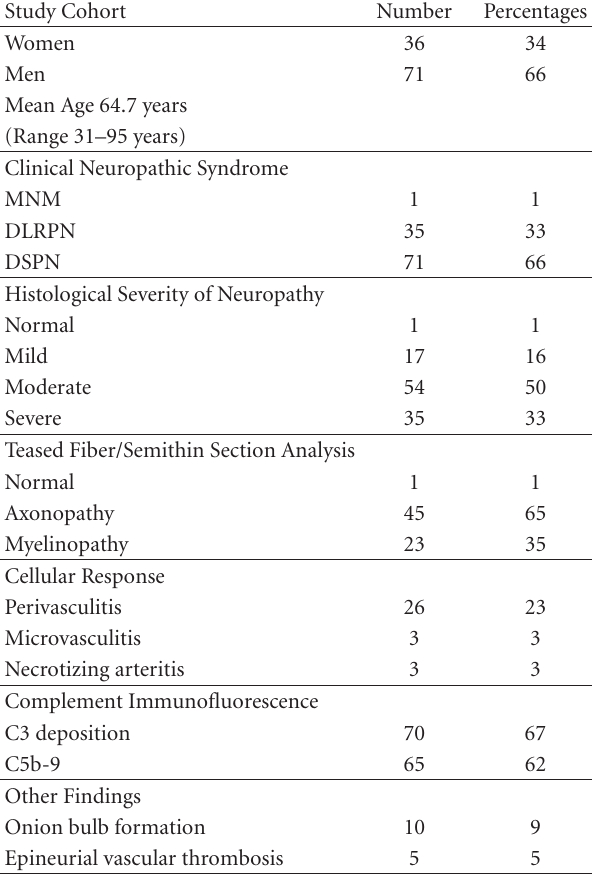
Table 1: Clinical Characteristics of 107 Patients and Diabetic Neuropathy.